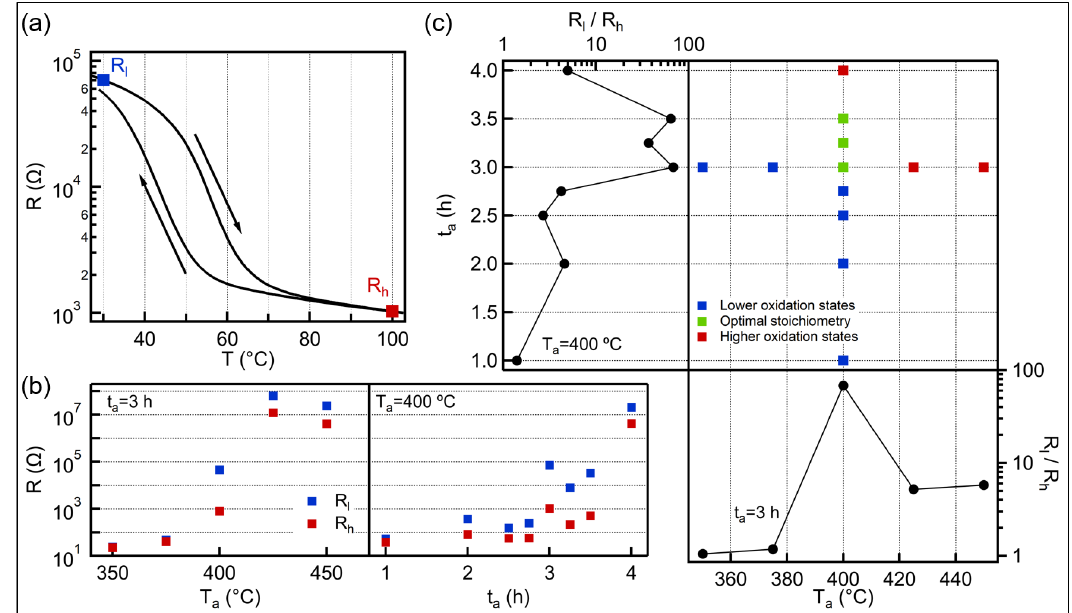
Figure 1. ( a ) Typical temperature dependent resistance curve of VO x film oxidized at T a = 400 ◦ C for t a = 3.0h. The blue/red dot marks the resistance at 30/100 ◦ C on the heating branch (R l and R h , respectively), whereas the arrows indicate the direction of the hysteresis curve. ( b ) Evolution of the low (blue dots) and high (red dots) temperature resistances as a function of annealing temperature (left panel) and annealing time (right panel), while the other oxidation parameters are fixed. The layers are considered to low oxygen content if the resistance is lower than 1 k Ω and high oxygen content if the resistance is higher than 1 M Ω during the heating cycle. ( c ) The applied annealing time and temperature combinations (middle panel), the colors of the dots indicate the oxidation state of the vanadium according to the electrical property. The resistance switching ratios (R l /R h ) are also shown as a function of the annealing temperature (bottom panel) and annealing time (left panel). The films with optimal stoichiometry exhibit good electrical switching